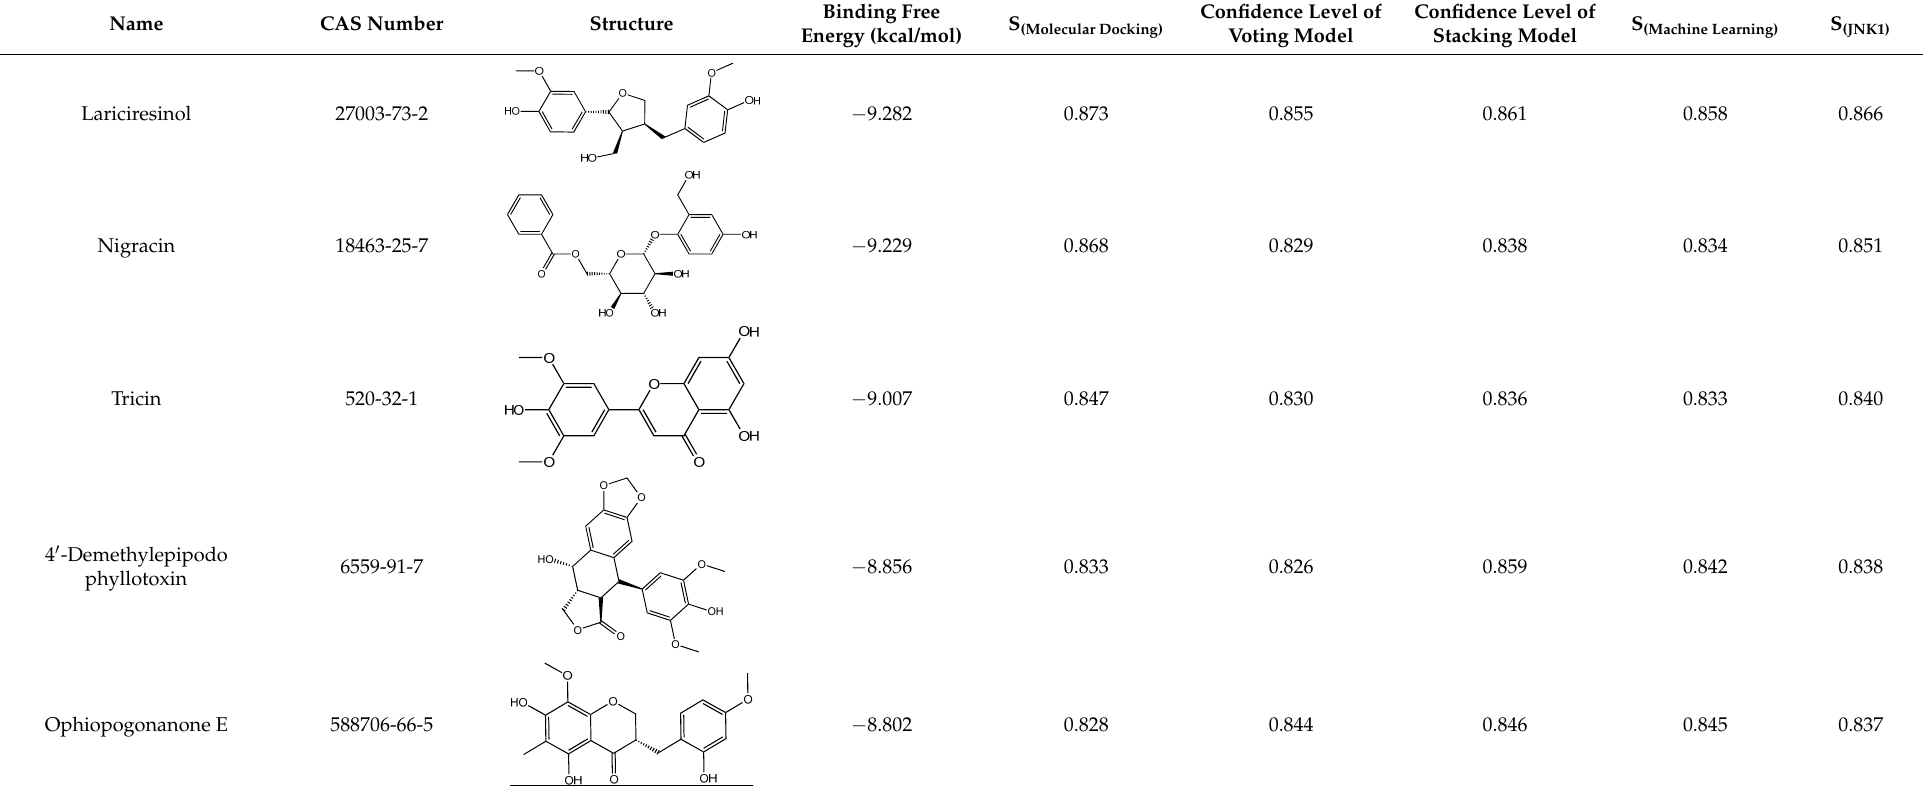
Table 2. The top five compounds with consensus analysis scores.